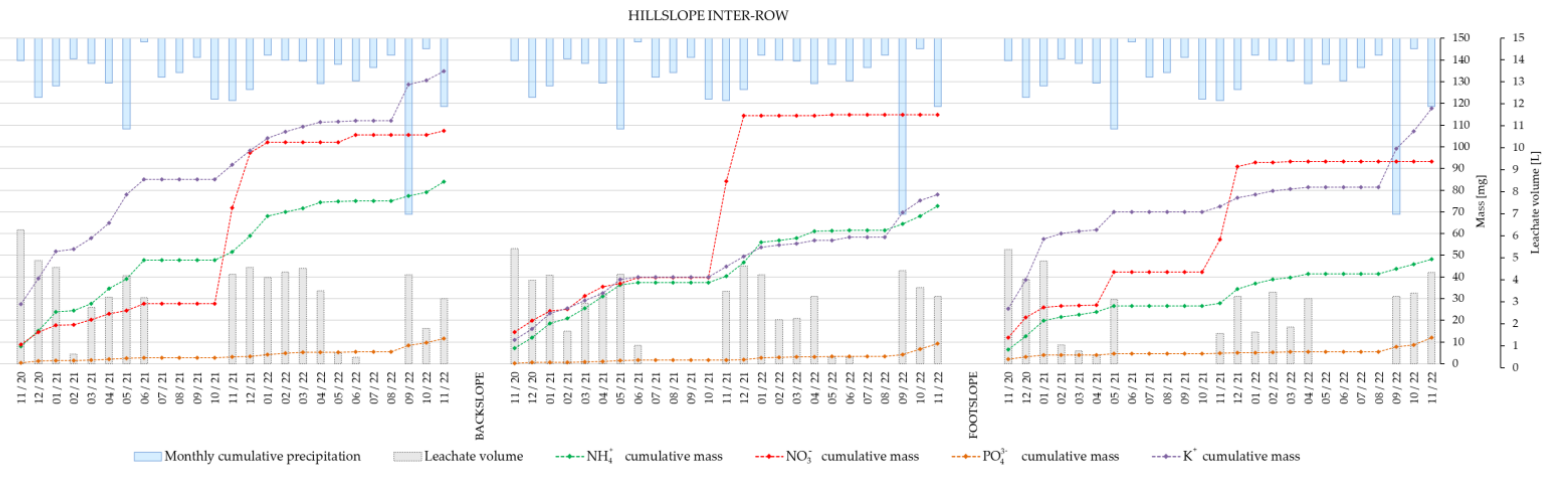
Figure 4. Nutrient ions cumulative masses in leachates, collected for two years (2 November 2020 to 25 November 2022), from wick lysimeters installed at hilltop, backslope and footslope of vineyard inter-row, presented with monthly cumulative precipitation and leachate volumes per sampling event.